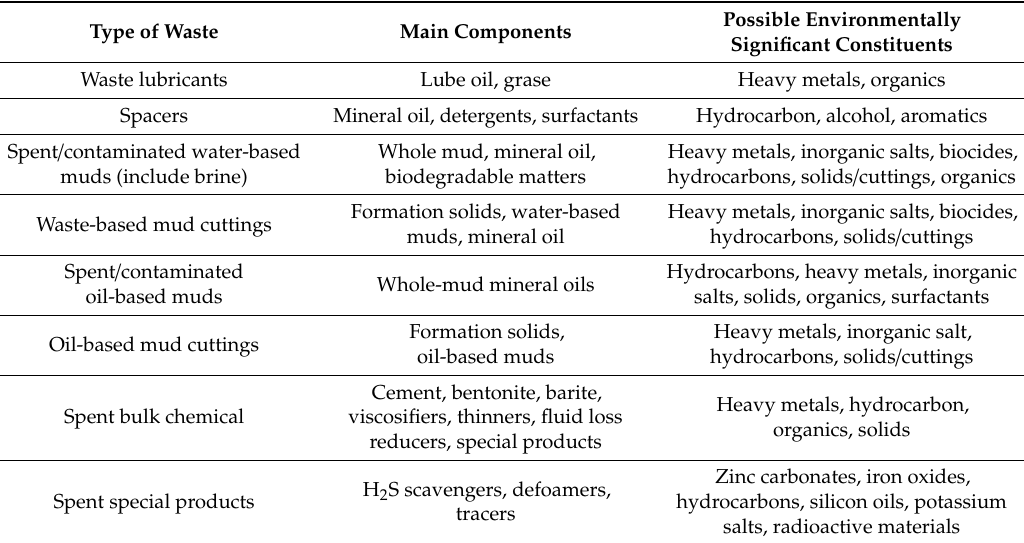
Table 1. Composition of waste generated through drilling activities